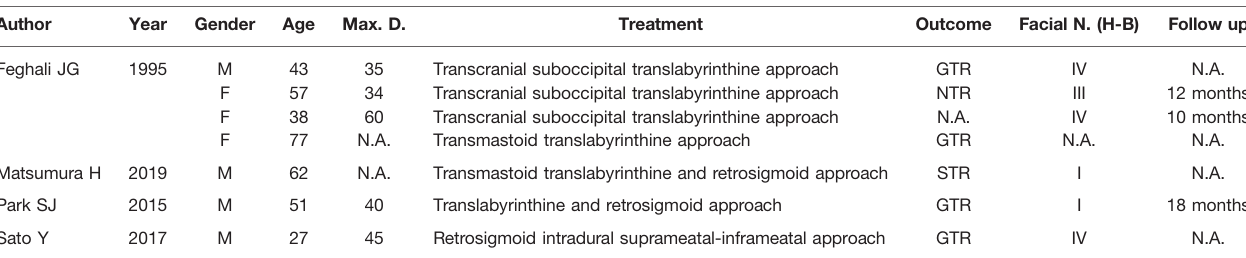
TABLE 1 | Literature review of large VS with temporal bone invasion.